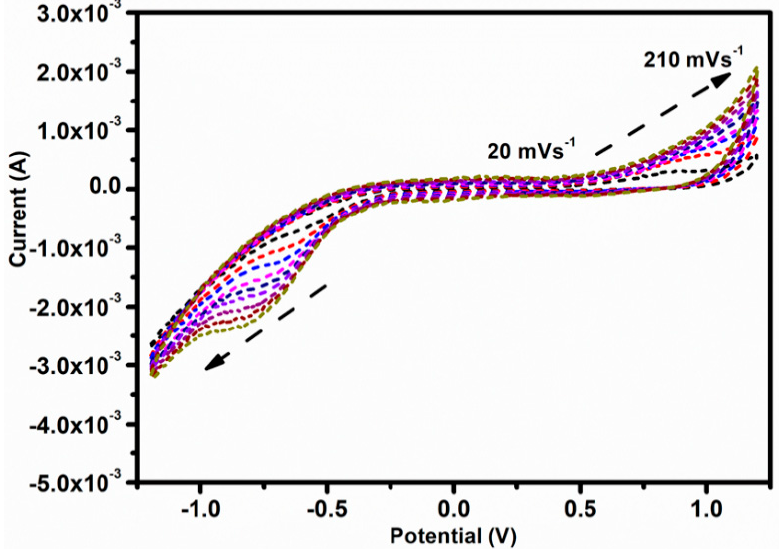
Figure 7. CVs of Fe 3 O 4 /Gr/CC obtained at various applied scan speeds of 20–210 mVs − 1 in 0.1 M PBS (pH 7.0).